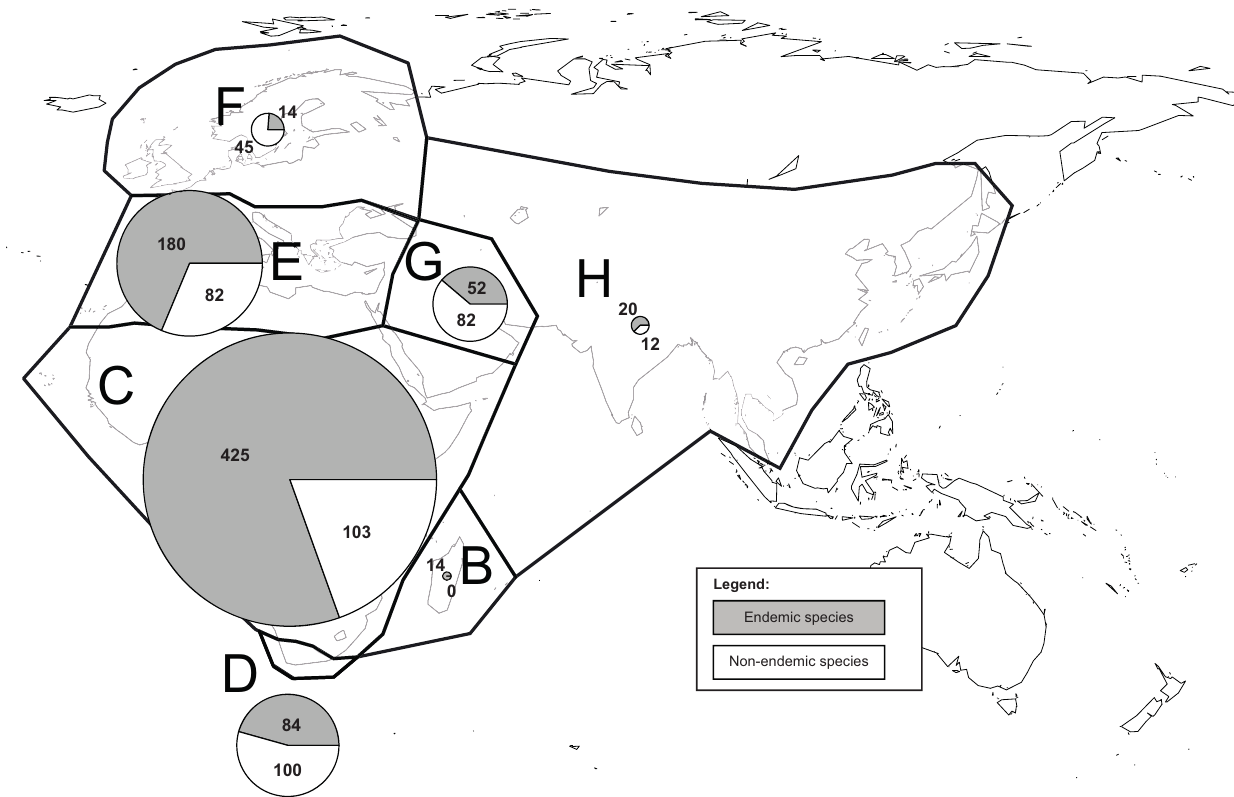
Figure 1. Area definition used to infer the biogeographical scenario of Hyacinthaceae. Species richness for each area is indicated. The numbers of species per area are based on Table S1. B, Madagascar; C, sub-Saharan Africa; D, Cape of South Africa; E, Mediterranean Basin; F, Northern Europe; G, Middle East; H, Asia. Area A corresponds to America and is not represented in this figure.